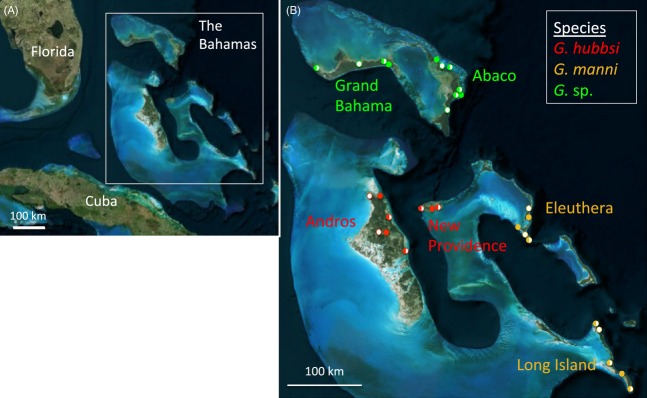
Map of (A) the study region in the northwestern Bahamas and (B) specific tidal creek collection localities for each Gambusia species on each island. Open circles: fragmented tidal creeks, filled circles: unfragmented tidal creeks, half-filled circles: both fragmented and unfragmented sites in close proximity.